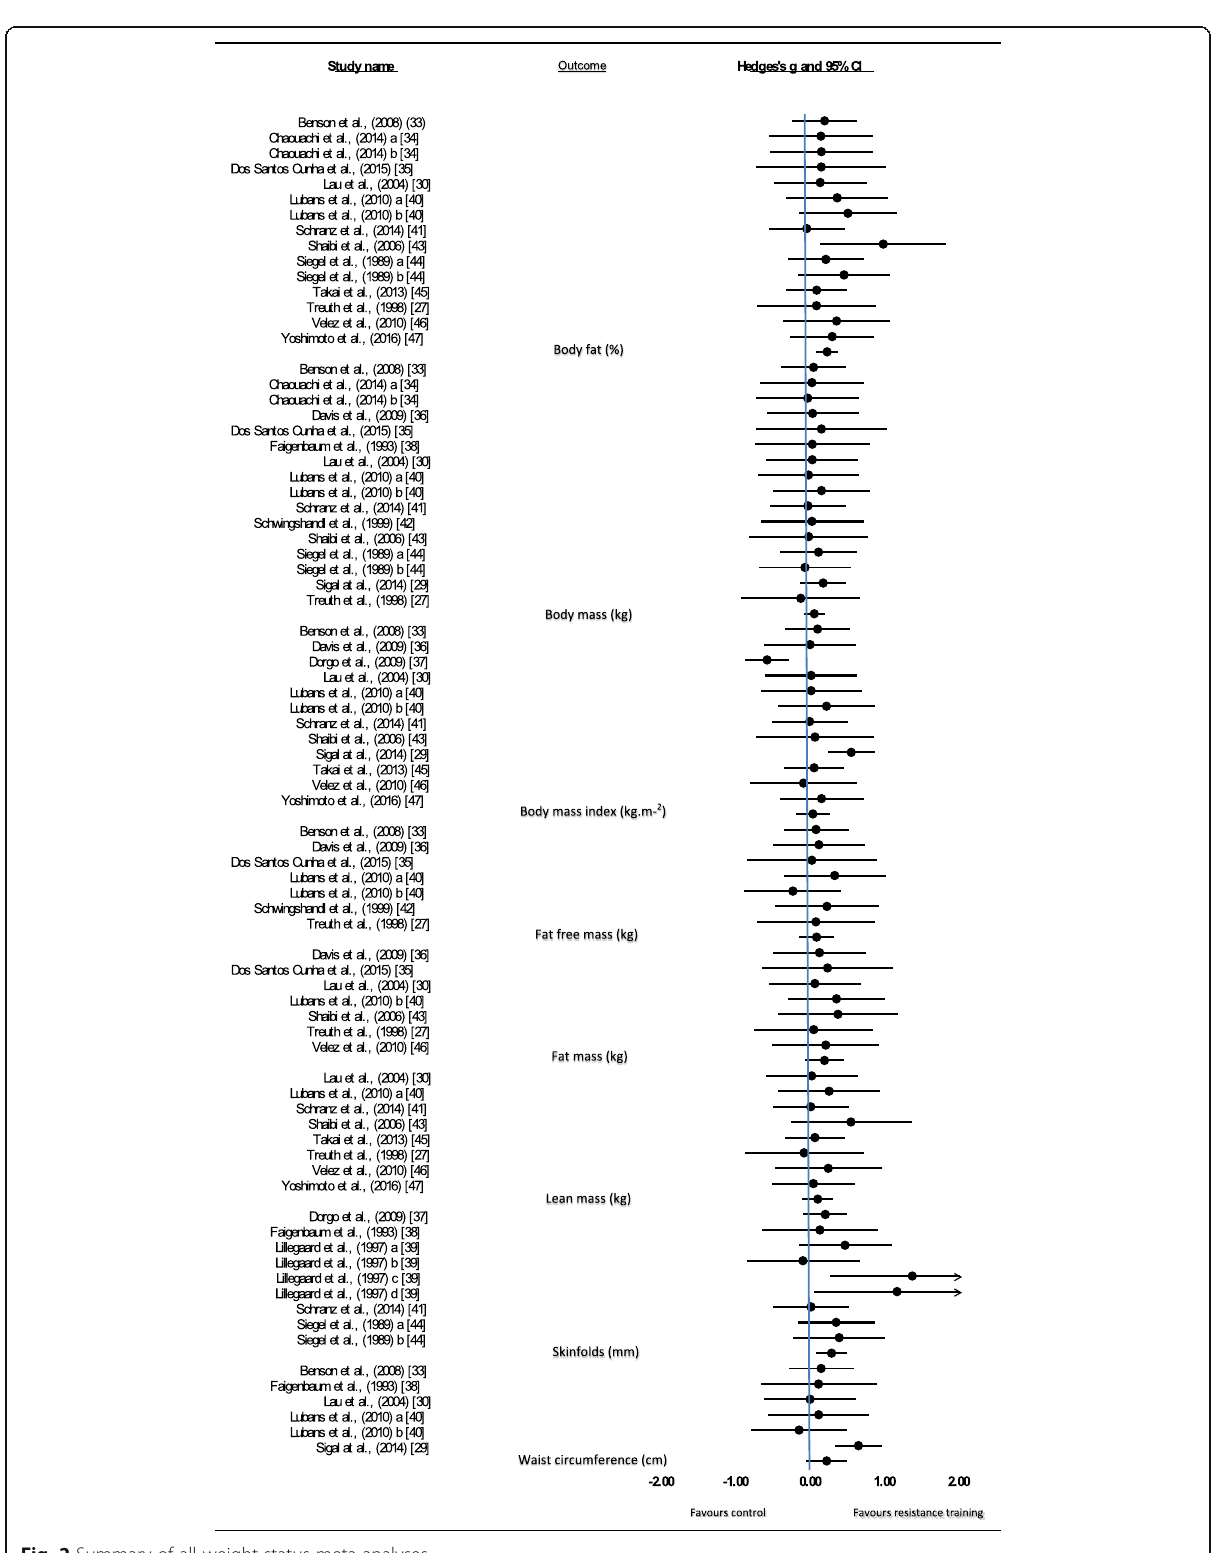
Fig. 2 Summary of all weight status